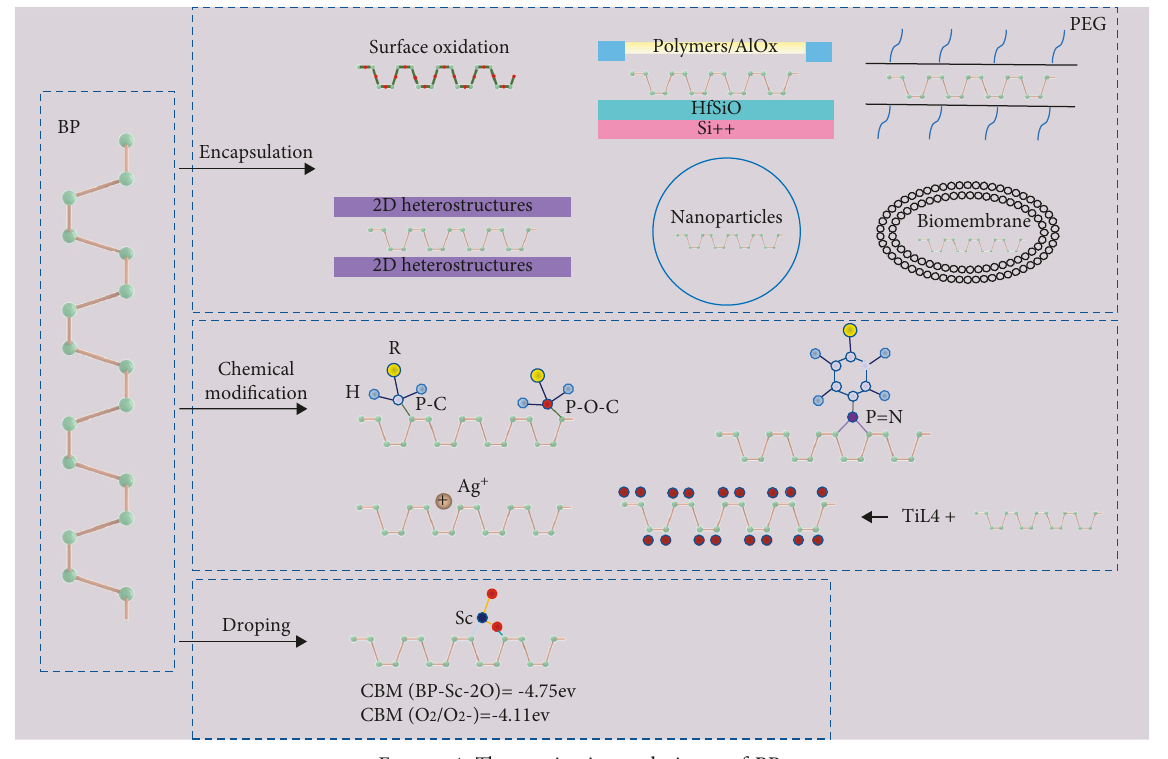
Figure 4: The passivation techniques of BP. Table 1: The strategies of modifications on